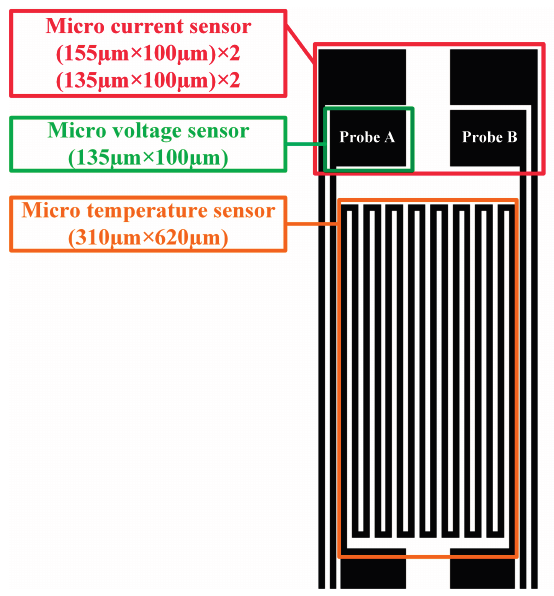
Figure 1. Structural dimensions of the flexible three-in-one microsensor.